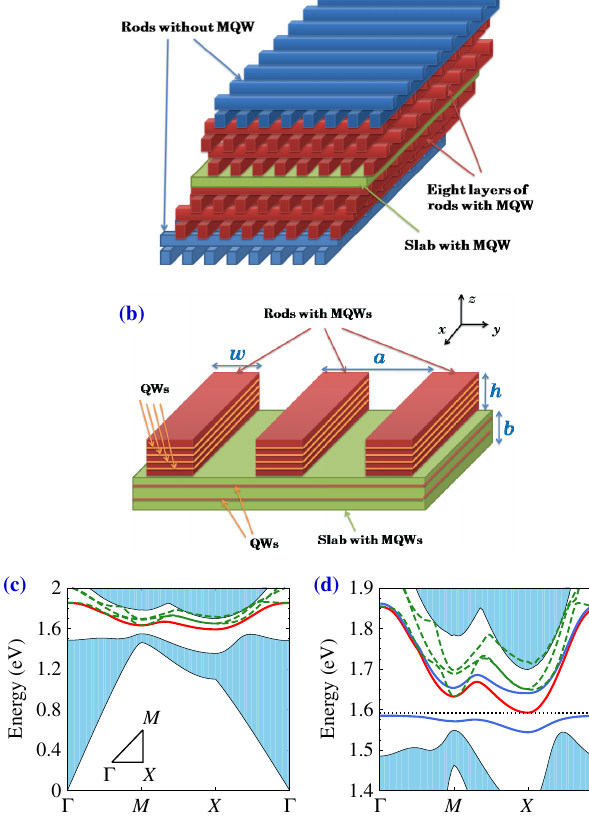
FIG. 1. Photonic crystal architecture and photonic band dispersion. (a) A slab layer sandwiched between two woodpile photonic crystals induces 2D photonic bands ( “ guided modes ” ) in ¼ 9 . 2% , where δω is the band-gap width the 3D PBG with δω = ω c and ω is the PBG central frequency. (b) QWs are grown in the slab c and the eight nearby layers of rods. Typically, a ≃ 360 nm, w ¼ 0 . 25 a ≃ 90 nm, h ¼ 0 . 3 a ≃ 110 nm, and b ¼ 0 . 06 a ≃ 20 nm. There are about 100 QWs with the same width. There are two QWs in the slab layer and about 12 QWs in each rod. The QWwidthsare chosentobe3,4,5,and6nmforcomparison,while the width of the barrier layers between QWs is fixed to be 5 nm. QWs are made of CdTe (dielectric constant 8.5), while the barriers and photonic crystals are made of Cd 0 Mg 0 Te (dielectric . 6 . 4 constant 7.5). In the regions with QWs, the dielectric constant is taken to be 8 (average of the two materials). (c),(d) Dispersion of the 2D guided modes (dashed green and solid red curves) and the bulk 3D photonic bands (shaded regions). The first Brillouin ≤ q ; q < π zone of the 2D guided modes is − π . The lowest 2D x y a a photonic band [the solid curves in (c) and (d)] is coupled with excitons [dotted curve in (d)] in QWs. The lower and upper polariton branches [solid blue curves in (d)] are depicted for exciton recombination in resonance with the lowest 2D guided mode. In this case, each QW width is 4 nm, the exciton- ¼ 1 . 59 eV, and the photonic lattice recombination energy is E X 0 constant is chosen to be a ¼ 360 nm. The exciton-photon- coupling strength and the on-resonance lower-polariton dispersion depth is 48 meV. Larger dispersion depth and higher BEC temperature are achieved by detuning the exciton-recombination energy above the lowest 2D guided